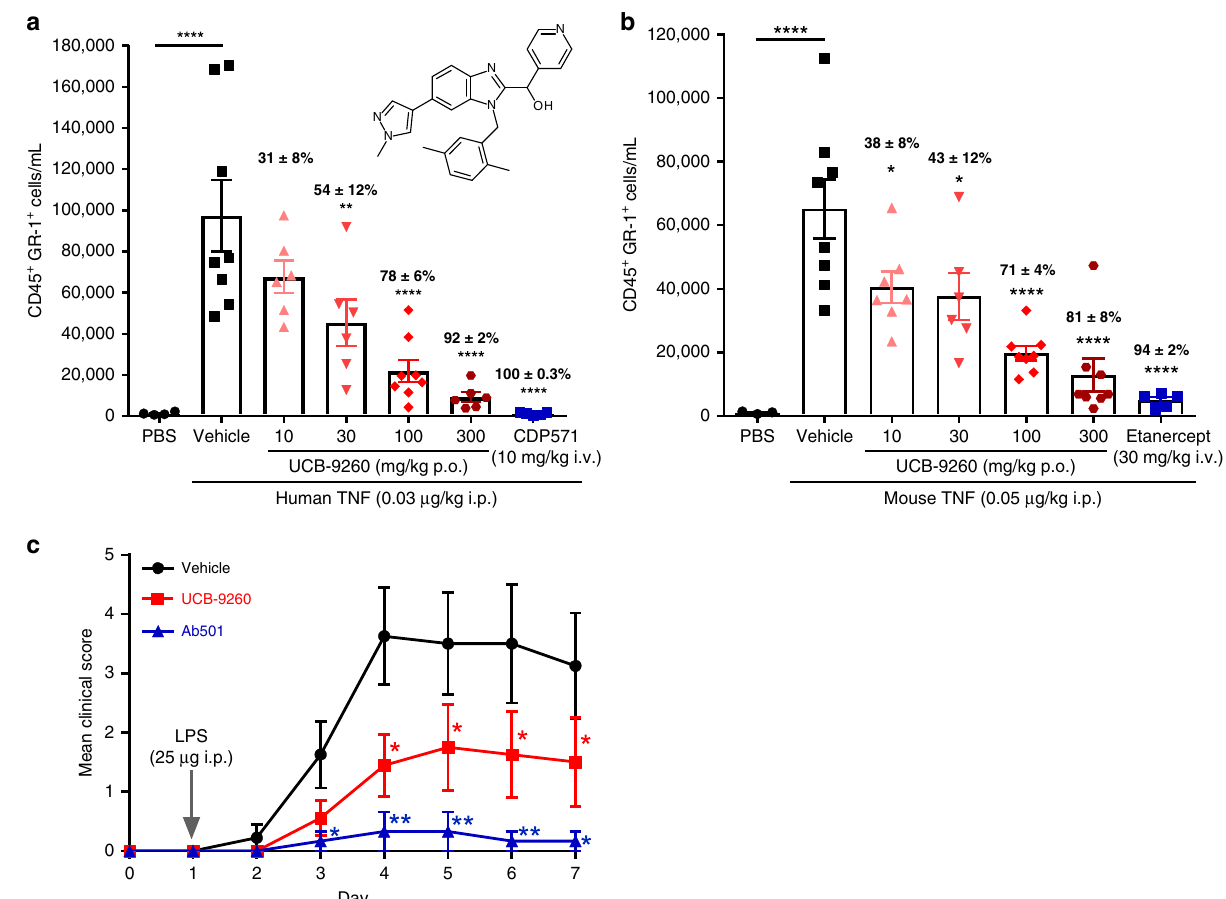
Fig. 6 Oral treatment with UCB-9260 inhibits TNF-driven functional effects in vivo. a UCB- 9260 (10 – 300 mg/kg po, PBS n = 4; vehicle n = 8; UCB- 9260 10, 30 and 300 mg/kg n = 6 and 100 mg/kg n = 8; CDP571 n = 5 mice) dose-dependently inhibits human and ( b ) mouse TNF-induced neutrophil recruitment to the peritoneal compartment in mice (PBS n = 3; vehicle n = 8; UCB- 9260 10 mg/kg n = 7, 30 mg/kg n = 6, 100 and 300 mg/kg n = 8; CDP571 n = 5 mice). c UCB- 9260 (150 mg/kg po bid) signi fi cantly reduces arthritis clinical score in the CAIA model (vehicle n = 8; UCB- 9260 n = 8 and AB501 n = 6 mice). Mean data ± standard error is shown. * p < 0.05, ** p < 0.01, *** p < 0.001 determined using one-way ANOVA with Dunnett ’ s